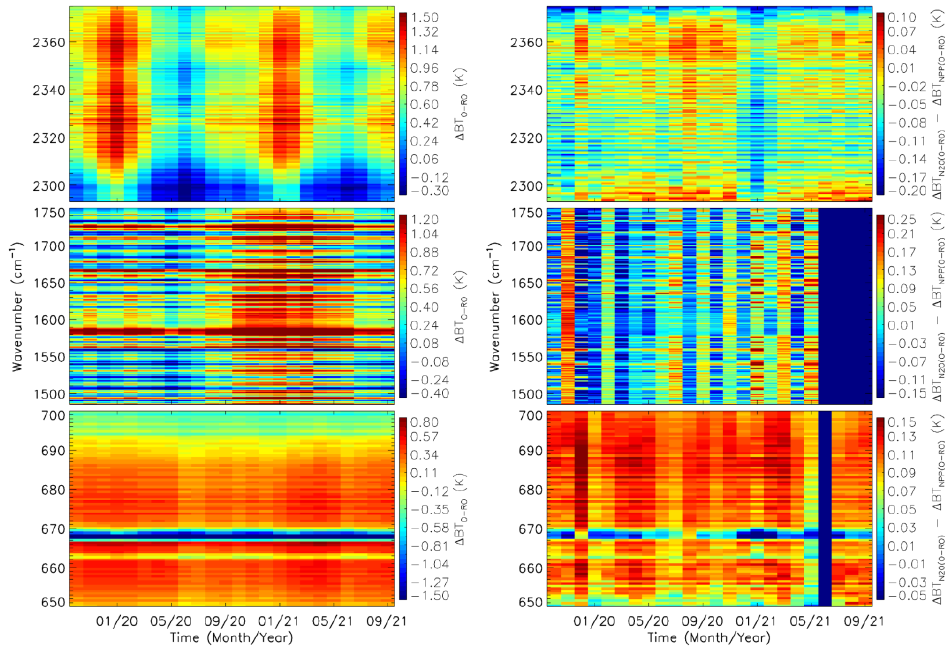
Figure 13. Same as Figure 12 except for results from the daytime.